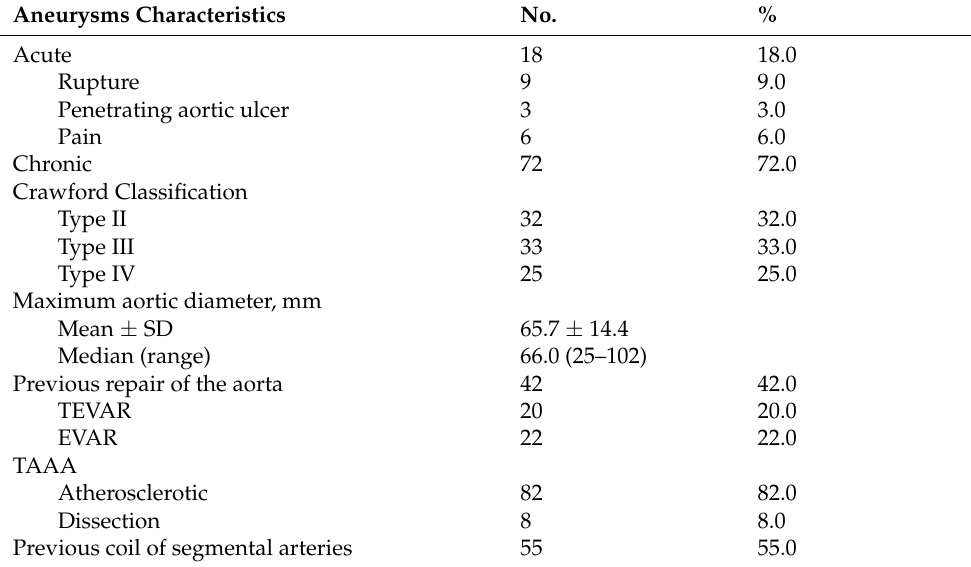
Table 3. Characteristics of thoraco-abdominal aortic